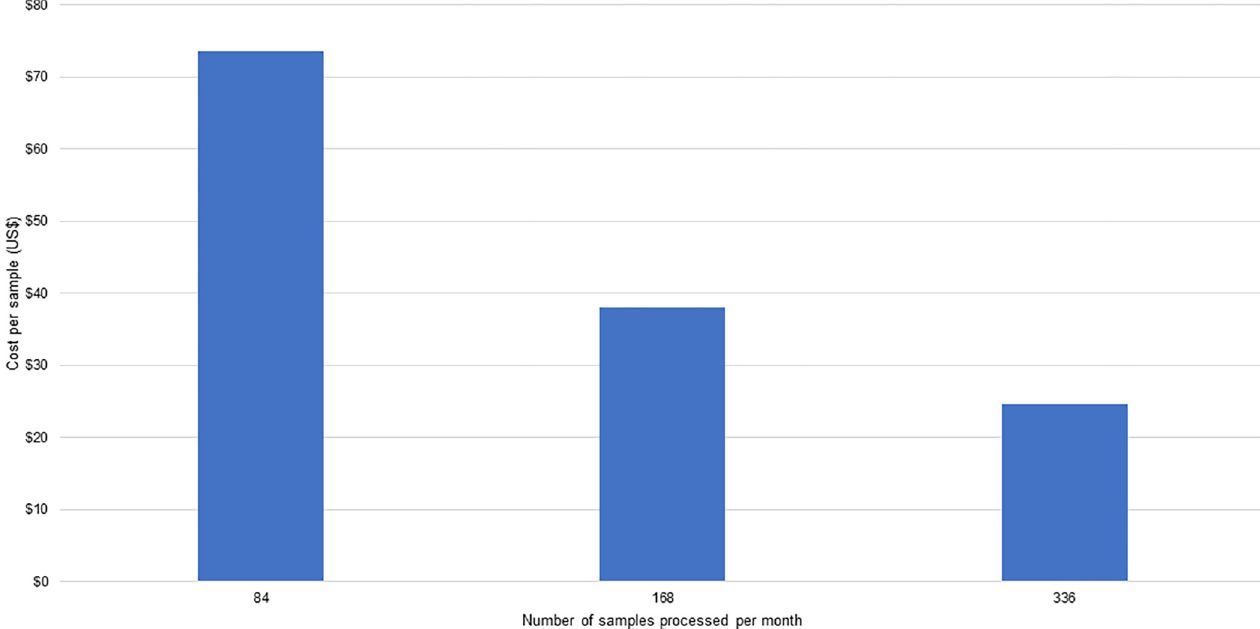
Fig 3. Per sample cost in US$, processed in a month, at the Blantyre pilot site.